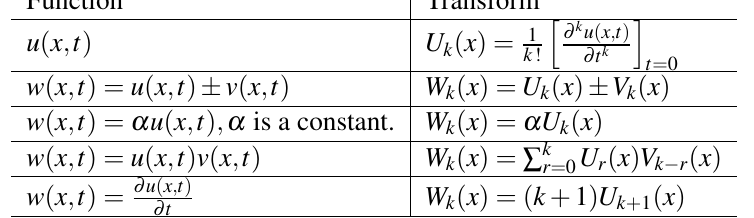
Table 3 Some properties of the